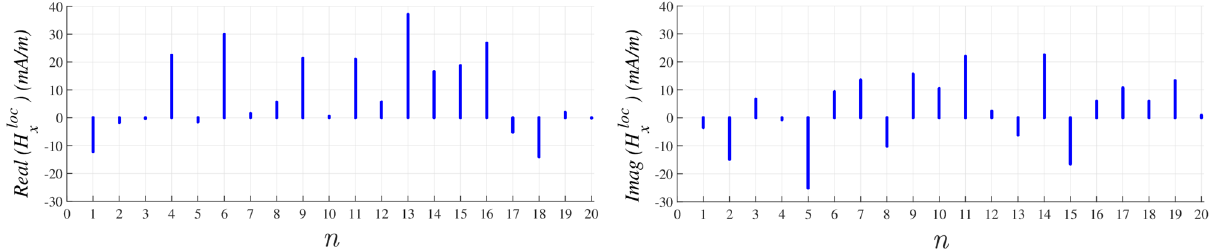
Figure 6. Real and imaginary part of evaluated Fourier series in Eq. (30) at each discreted ϕ angle.